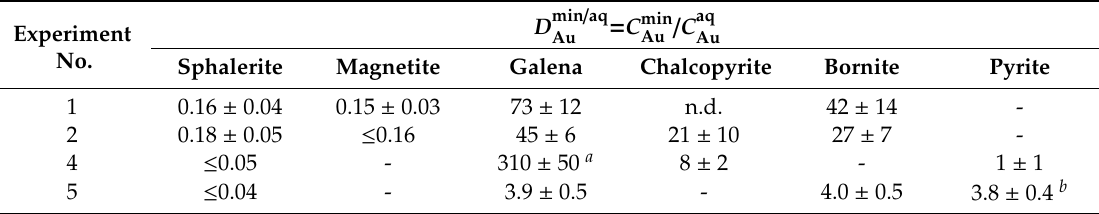
Table 3. Gold partition coe ffi cients in the mineral- aqueous fluid system: LA-ICP-MS data for bulk of crystals grown simultaneously at 450 ◦ C and 1 kbar. Experiment